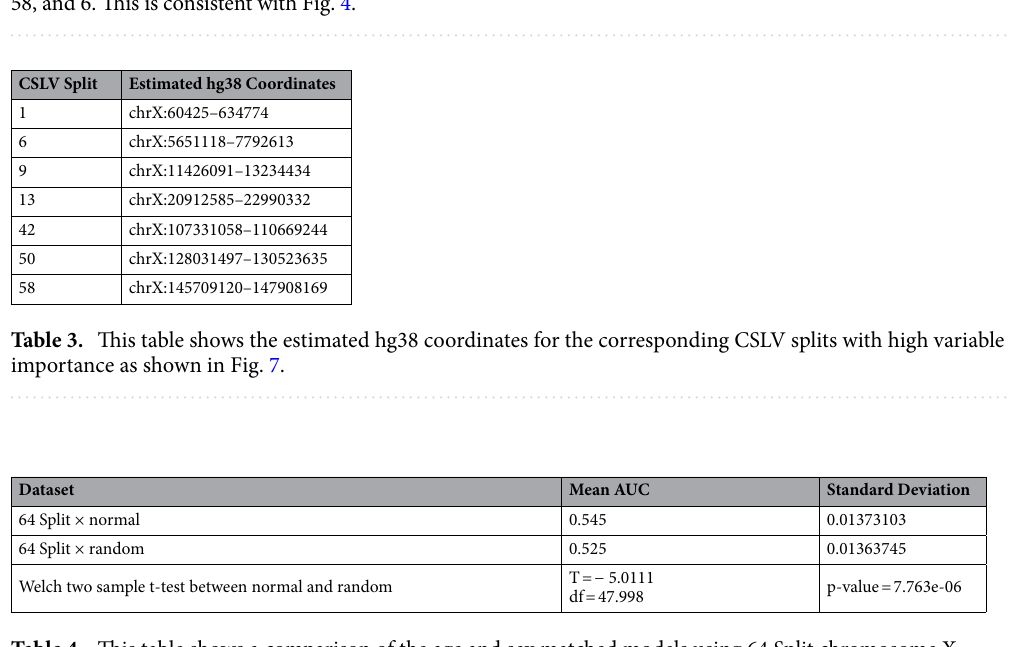
Figure 7. This variable importance heatmap shows the variables which most affected the performance and outcome of decisions made by the specified model. A value closer to 1.0 indicates higher importance of that variable. In most of the models we find that the CSLV values were mostly centered around split 50, 1, 9, 42, 13, 58, and 6. This is consistent with Fig. 4.